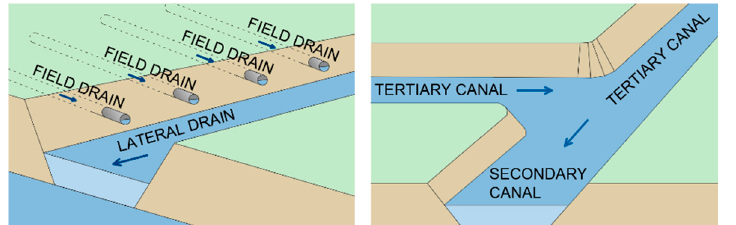
Figure 2. Typical scheme of junctions on the canal network: outlet of field drains into lateral drain (left); formation of secondary canal on the junction of two tertiary canals (right).